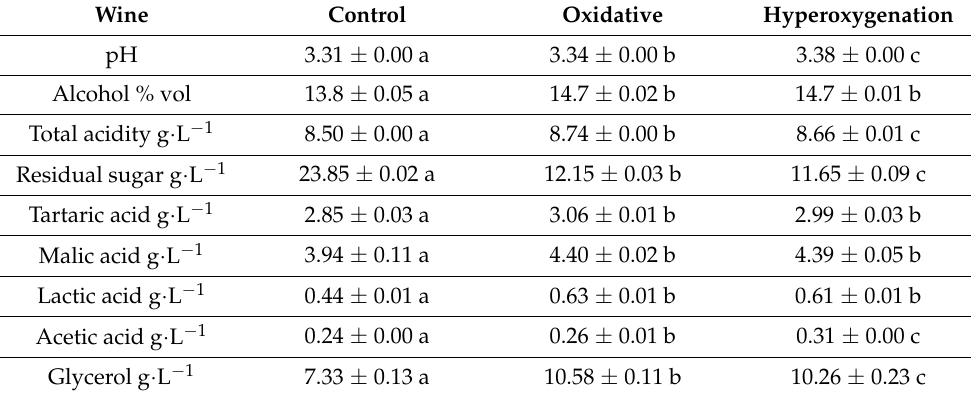
Table 1. Basic analytical parameters of final wines. Wine Control